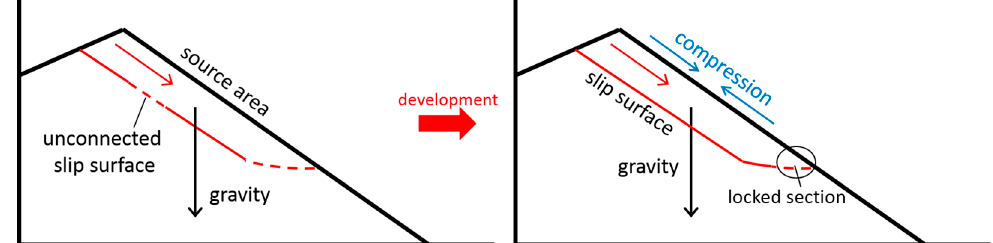
Figure 11. A simplified diagram of the expansion of the slip surface. The red line represents the sliding surface of the source area. Referring to Wang et al. 2018, the position of the locked section is located as